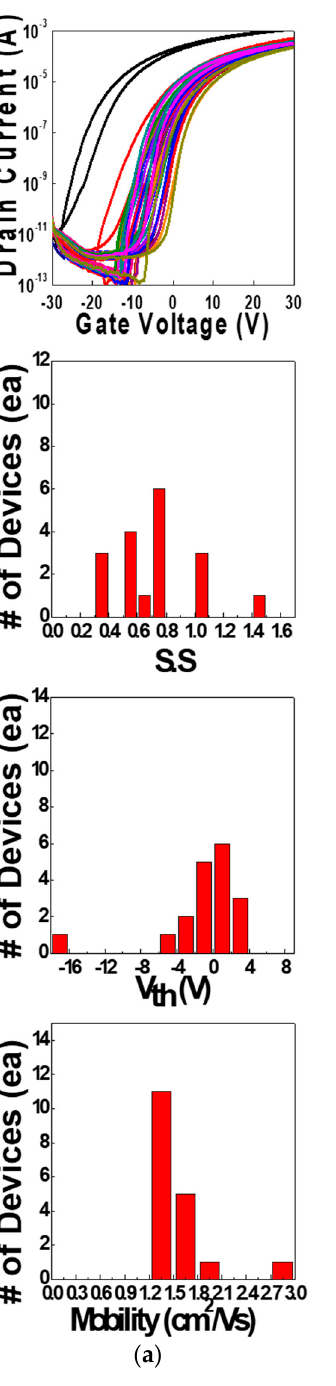
Figure 6. Log 10 (I D ) vs V G transfer curves and the statistical data of subthreshold swing (S.S.) values, threshold voltages ( V th ) and saturation field effect mobilities ( a ) before and ( b ) after PSPI-passivation. Table 1. The average values, uniformities and standard deviations of saturation mobilities ( μ FE ) and subthreshold swings ( a ) before and ( b ) after PSPI-passivation are shown. The uniformity values were calculated by [(maximum − minimum)/(2·average)] × 100.